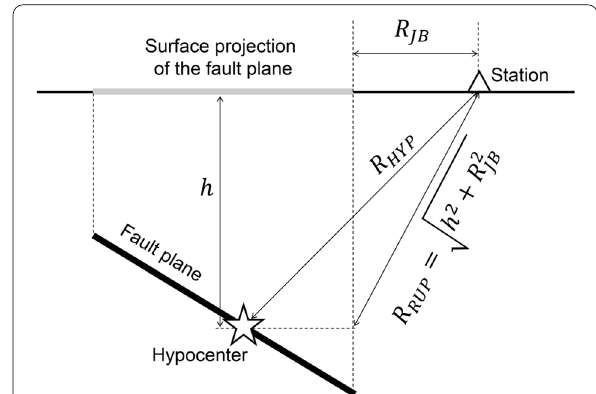
Fig. 2 Vertical cross section for the geometry of R HYP , R JB , and R RUP . The thick black line shows the fault surface; the star illustrates the hypocenter location, the triangle indicates the site location, and the gray shadow line indicates the surface projection of the fault